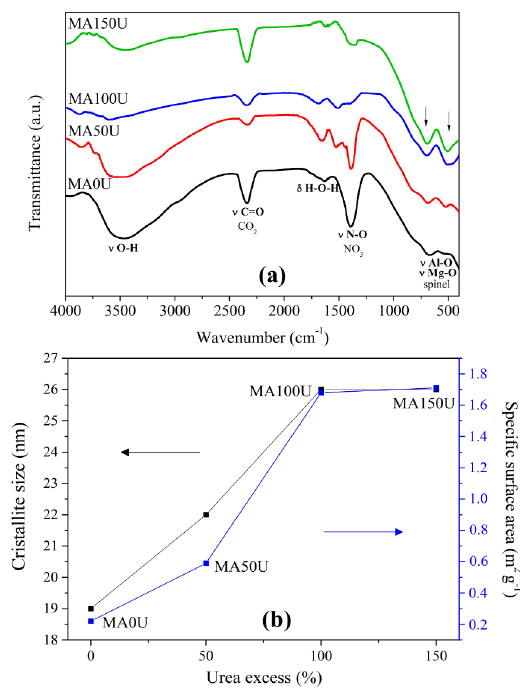
Figure 2. (a) FTIR spectra of the samples. (b) Crystallite sizes (XRD) and specific surface area (BET) of the solids, in function of the urea excess.